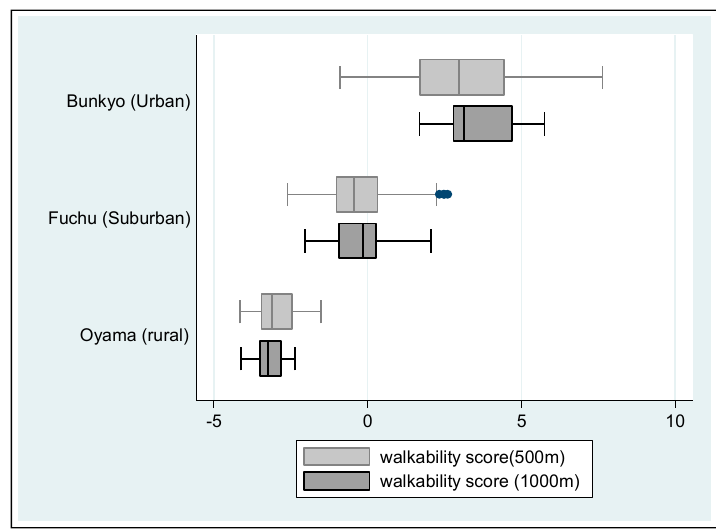
Figure 1. Distribution of individual walkability score by city of residence Note: Box-whisker plot indicates median line, quartile box, whiskers for the most extreme cases inside 1.5× interquartile range (IQR), and outliers.